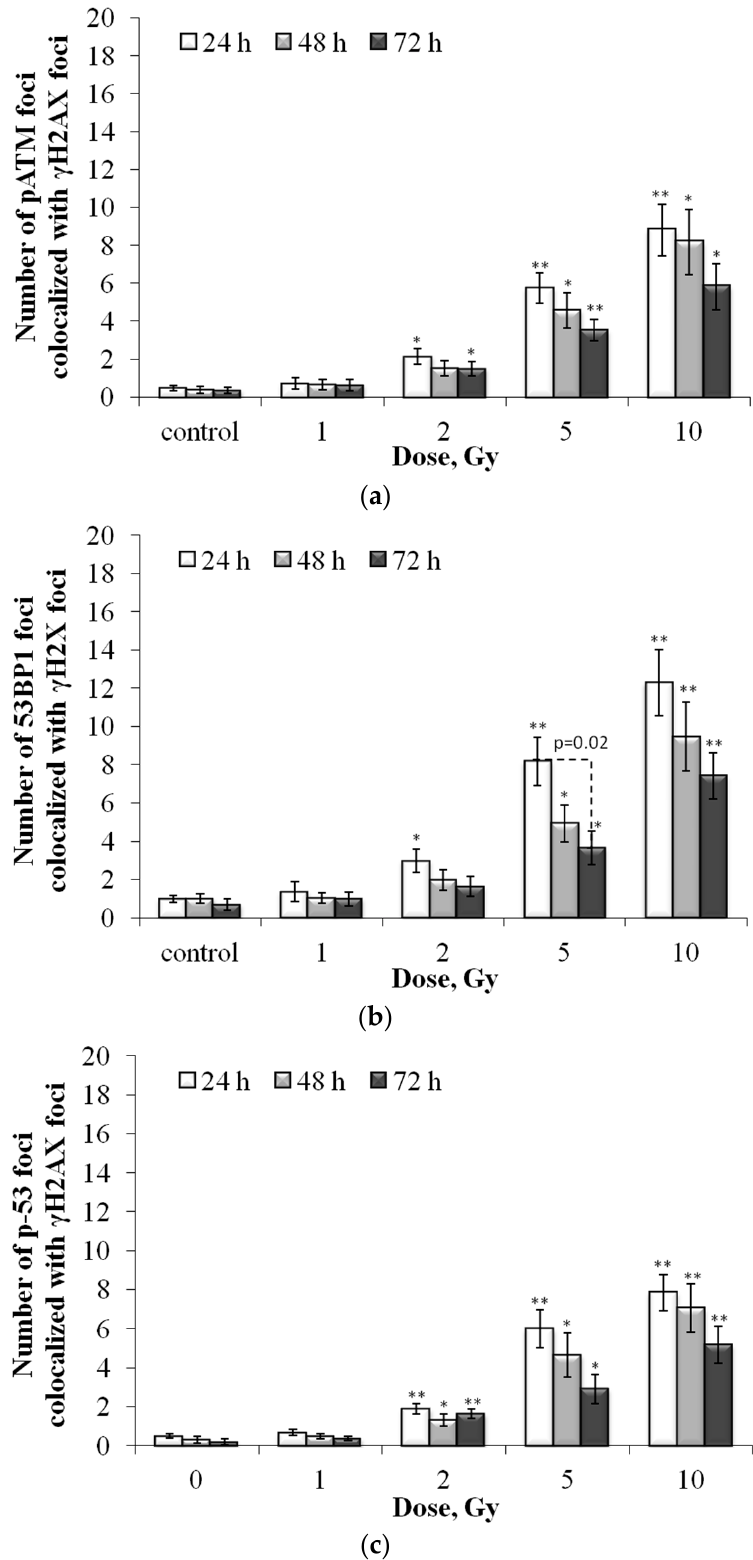
Figure 5. Dose-dependent changes in the number of pATM ( a ), 53BP1 ( b ) and p-p53 ( c ) foci colocalized with γ H2AX foci in human fibroblasts 24 h, 48 h and 72 h after irradiation. Data are means ± SE of three independent experiments. * p < 0.05 and ** p < 0.01—compared with the corresponding time of